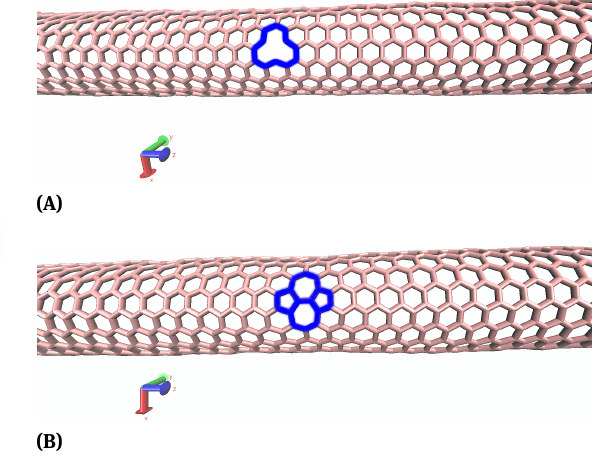
Figure 4: Types of single defect in nanotubes. (A) a single atom vacancy in nanotube, (B) a SW defect in nanotube